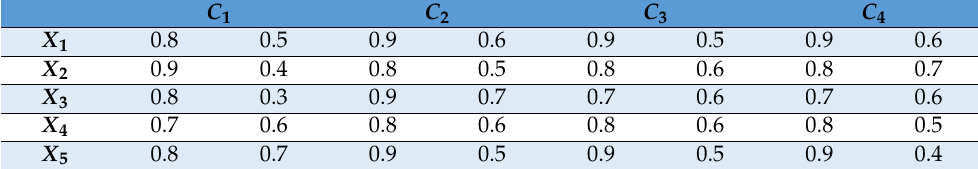
Table 4. Expert e 3 about energy resources under the given